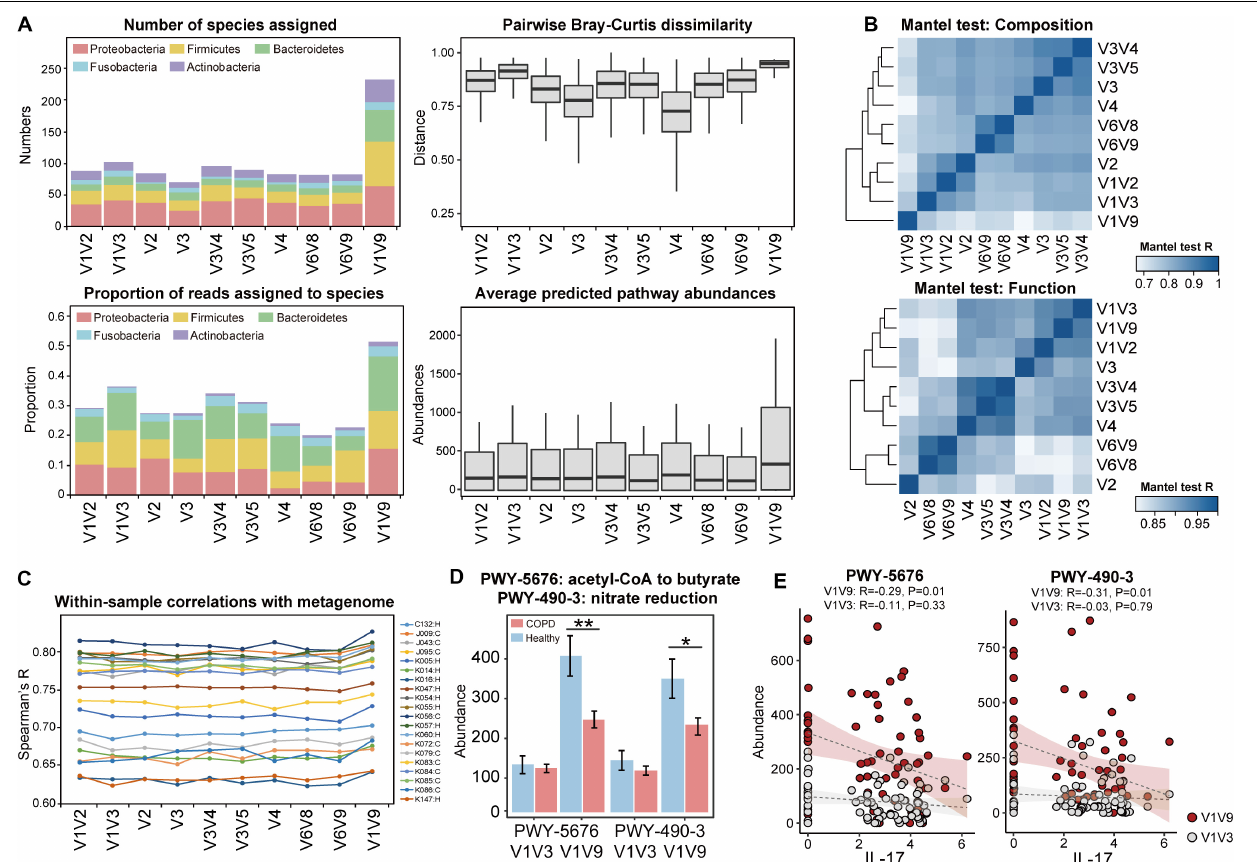
FIGURE 5 | Systematic comparison of full-length 16S data and sub-region data for taxonomic diversity and functional inference. (A) Comparisons between the full-length 16S data and the sub-region data, in terms of (1) the number of species-level taxa assigned, (2) the proportion of reads that can be assigned to species, (3) the pairwise Bray-Curtis dissimilarity across all samples, and (4) the average abundances of pathways predicted by PICRUSt2. (B) Heatmap showing similarity in compositional and functional profiles between the full-length 16S data and data for individual 16S sub-regions. Mantel test for Bray-Curtis dissimilarity was performed to assess the profile-level correlations. (C) The correlation between PICRUSt2-inferred genes and the same genes in the actual metagenome, within each of the 20 samples. The sample IDs and their corresponding groups (COPD: C , Healthy: H ) were indicated. (D) The PICRUSt2-inferred abundances of the two pathways ‘PWY-5676: acetyl-CoA fermentation to butyrate’ and ‘PWY-490-3: nitrate reduction’ in COPD and controls using the full-length (V1V9) and V1V3 data (** FDR P < 0.01, * FDR P < 0.05). (E) The two pathways showed negative correlations with IL-17, which was more pronounced when inferred from full-length 16S sequences than V1V3